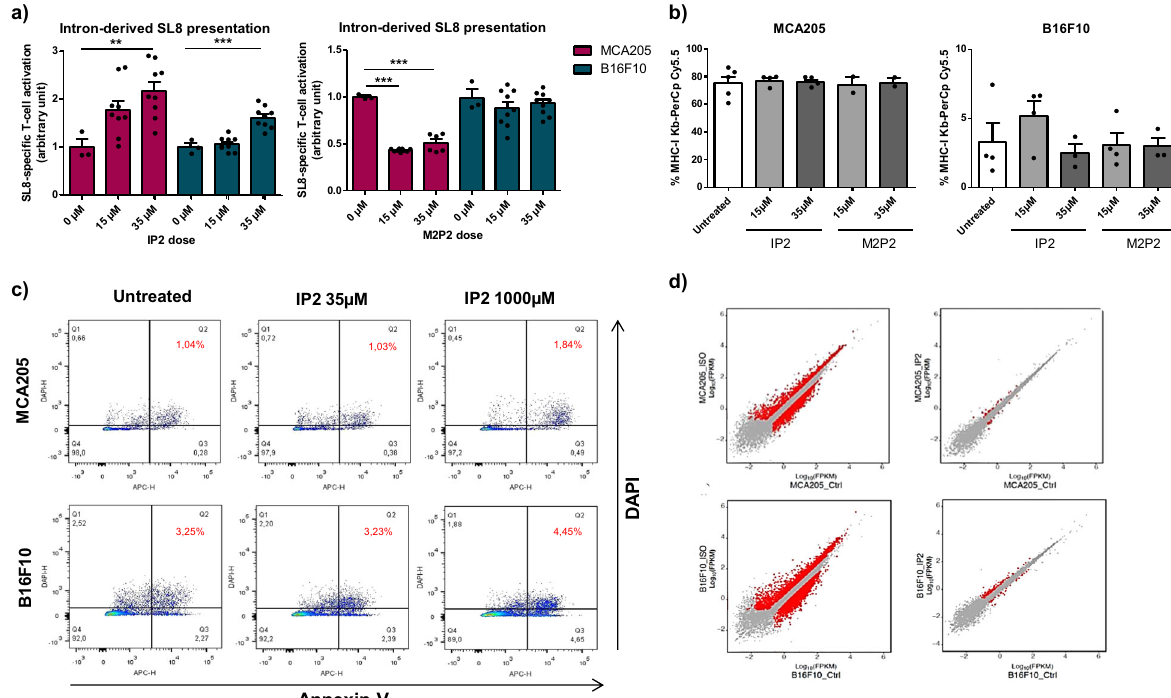
Fig. 2 The derivative IP2 retains the properties of the parent isoginkgetin on antigen presentation with reduced cytotoxicity. a SL8-speci fi c B3Z T-cell activation after co-culture with MCA205 fi brosarcoma and B16F10 melanoma both transiently expressing the intron-derived SL8 epitope and treated for 18 h with IP2 (left panel) or M2P2 (right panel) at indicated doses. Unspeci fi c B3Z T-cell activation was considered to normalize the results. Data are means ± SEM of relative B3Z T-cell activation for at least three biological replicates. b Analysis by fl ow cytometry of H-2K b expression at the surface of MCA205 fi brosarcoma (left panel) and B16F10 melanoma (right panel) treated with IP2 or M2P2 for 18 h at indicated doses. Data are means ± SEM of H-2K b frequency for three biological replicates. c Analysis by fl ow cytometry of the apoptotic status of MCA205 and B16F10 cells treated with 35 µ M or 1000 µ M of IP2 for 18 h and stained with DAPI and Annexin V-APC. Data highlight the proportion of late apoptotic cells (top right quadrant) and are representative of three independent experiments. d Comparison of gene expression pro fi le between isoginkgetin-treated (left panels) and IP2-treated (right panels) MCA205 fi brosarcoma (top panels) and B16F10 melanoma (bottom panels). FPKM Fragments Per Kilobase per Million mapped fragments. ** P < 0.01, *** P < 0.001 (One-way